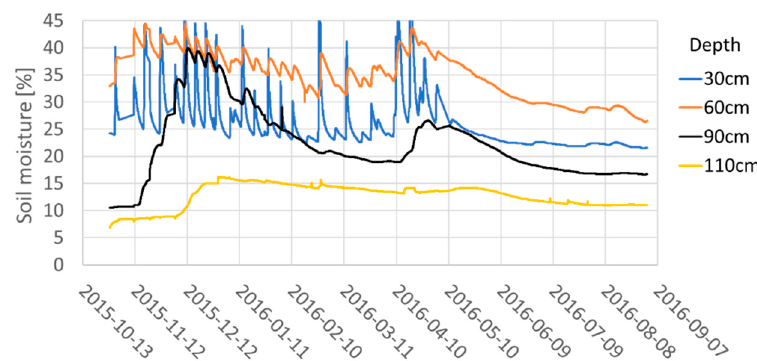
Figure 14. Soil moisture measurements of Station 3, at Block 3, Unit 1. Throughout the pit-hardening period (12/15/2015–02/15/2016), an RDI was applied. This effect is more noticeable at the 0.9 m depth sensor.